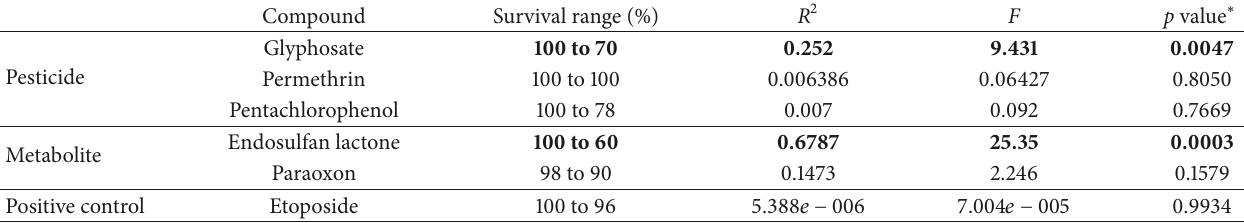
Table 3: Cytotoxic effect of pesticides and metabolites that induced double-strand breaks.